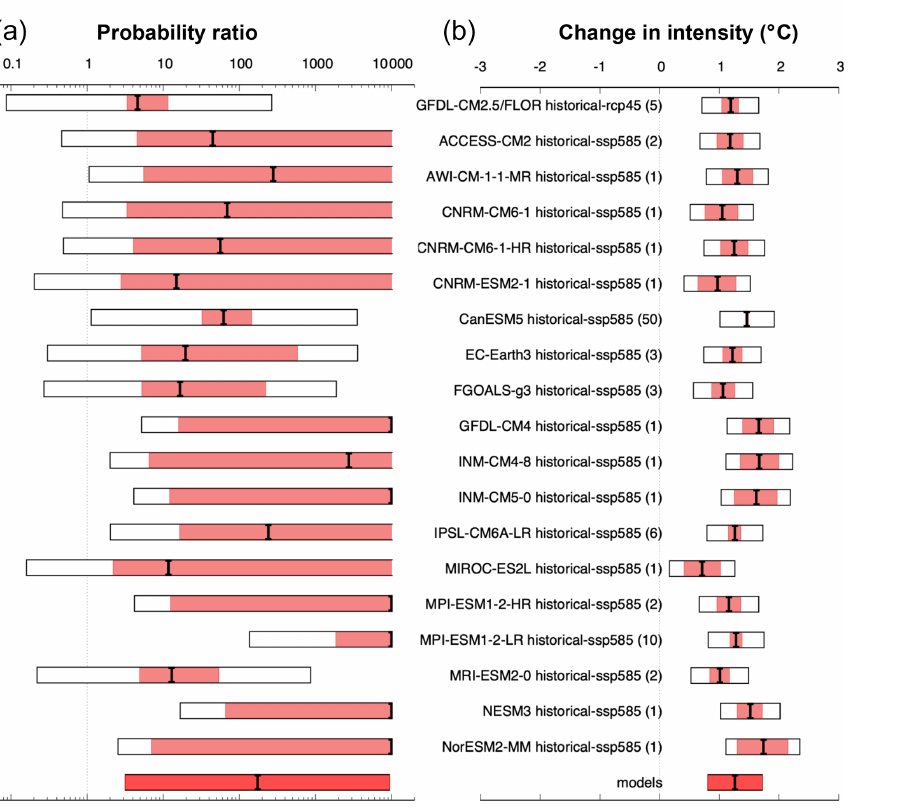
15 years with a lower bound of 1.5 years (not shown) to